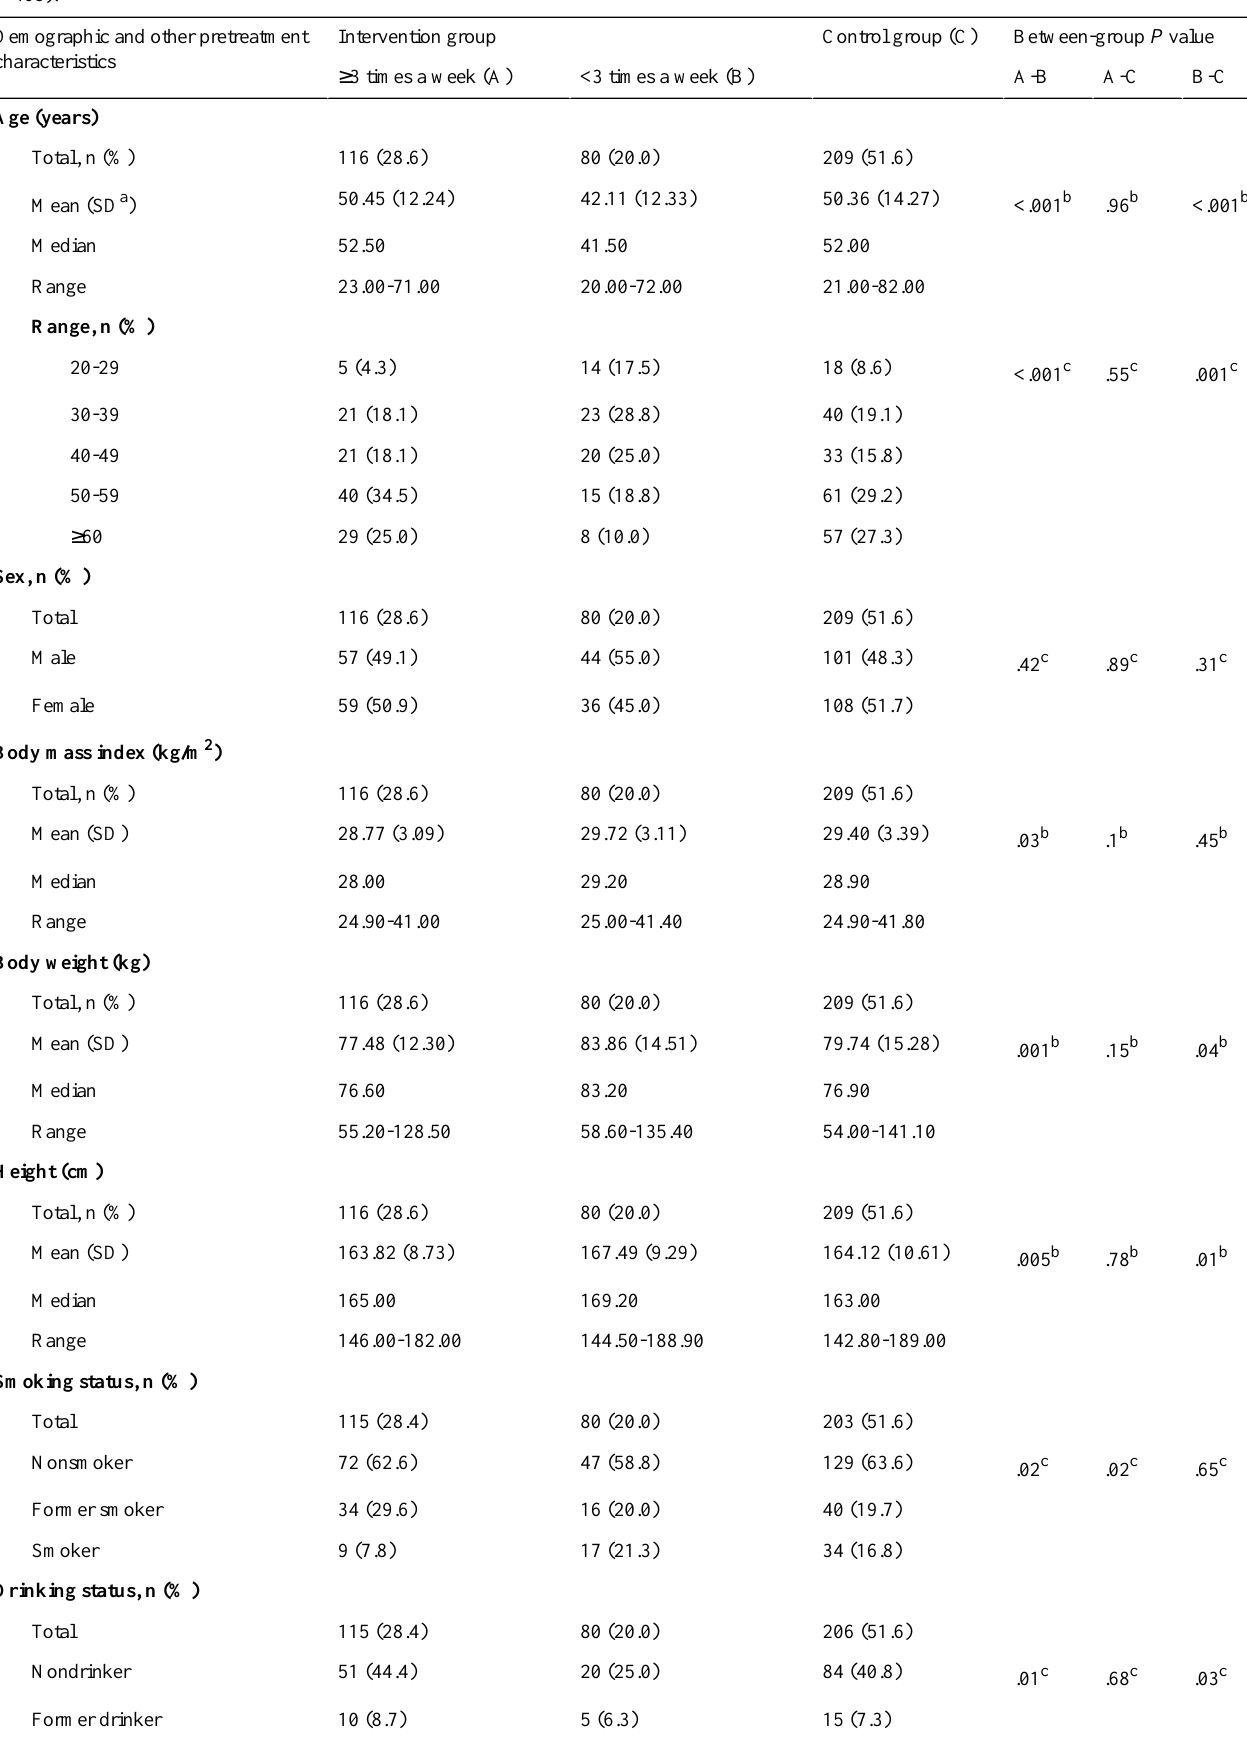
Table 1. Demographic and other pretreatment characteristics (intention-to-treat set) by the weekly mean number of anthropometric measurements